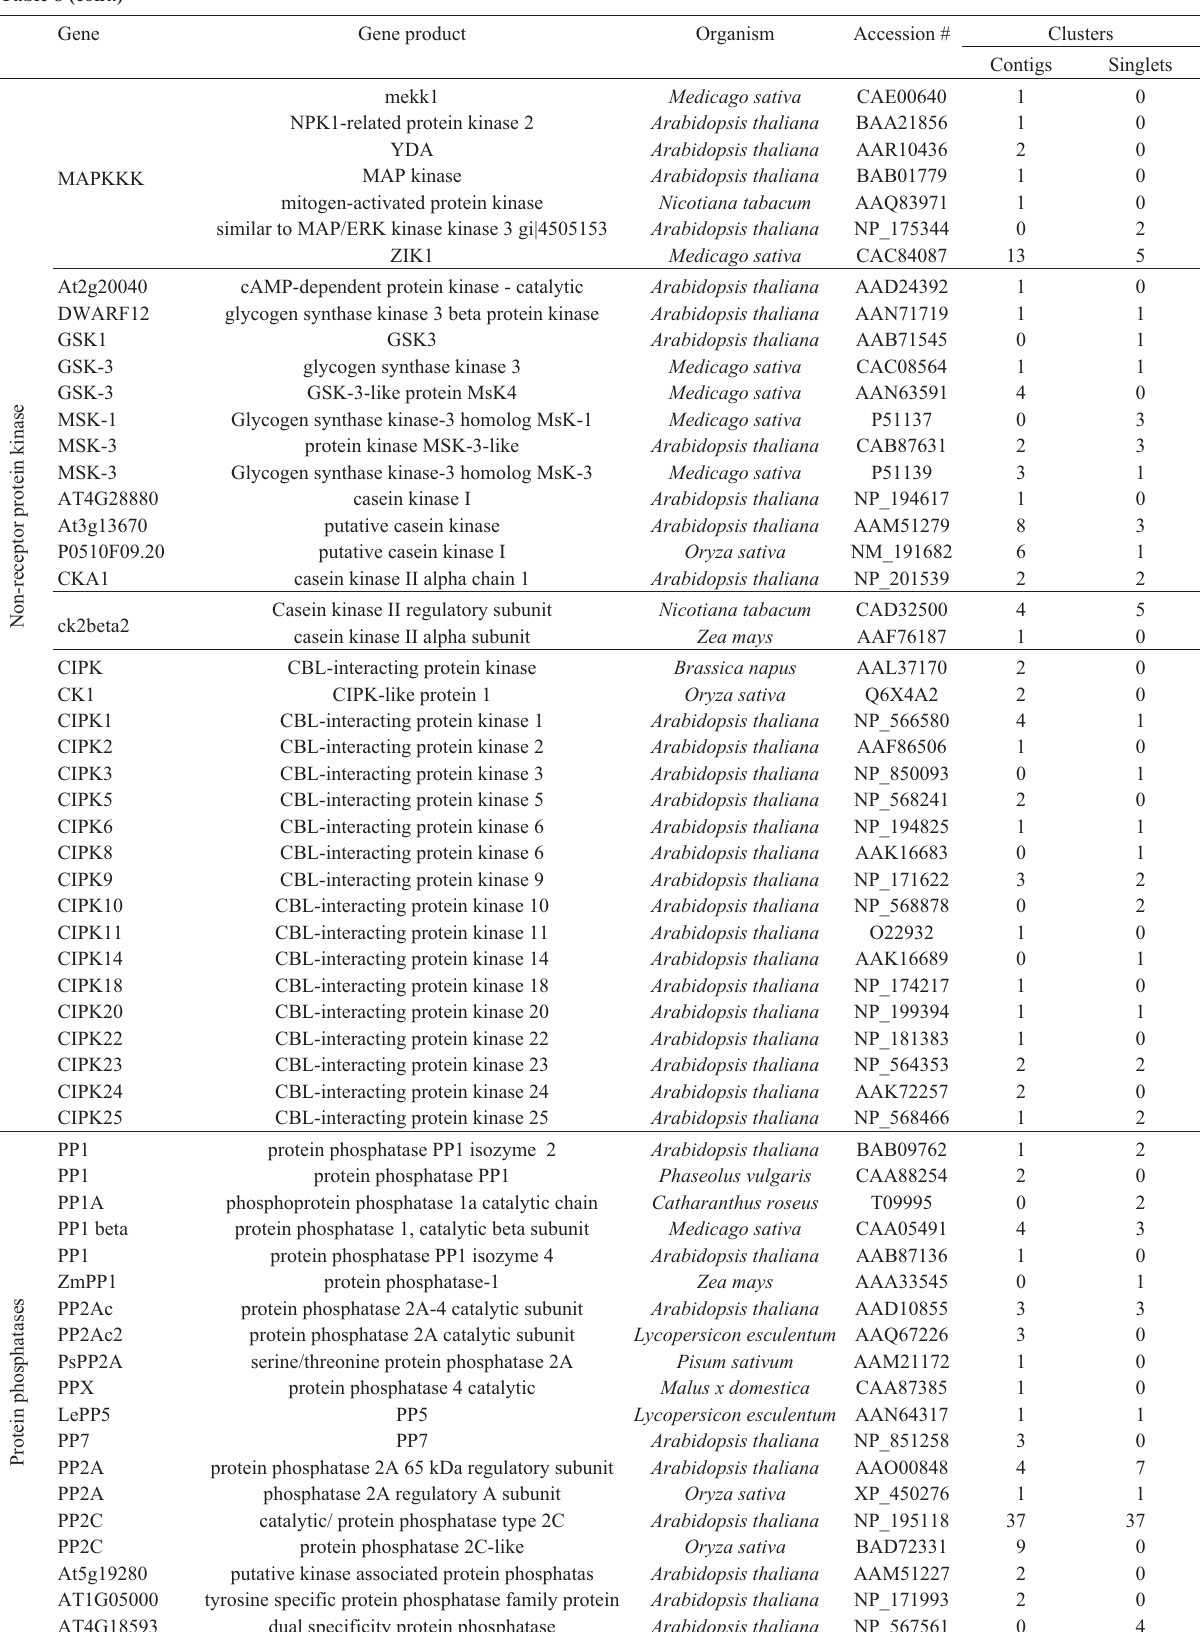
Table 8 (cont.) Gene Gene product Organism